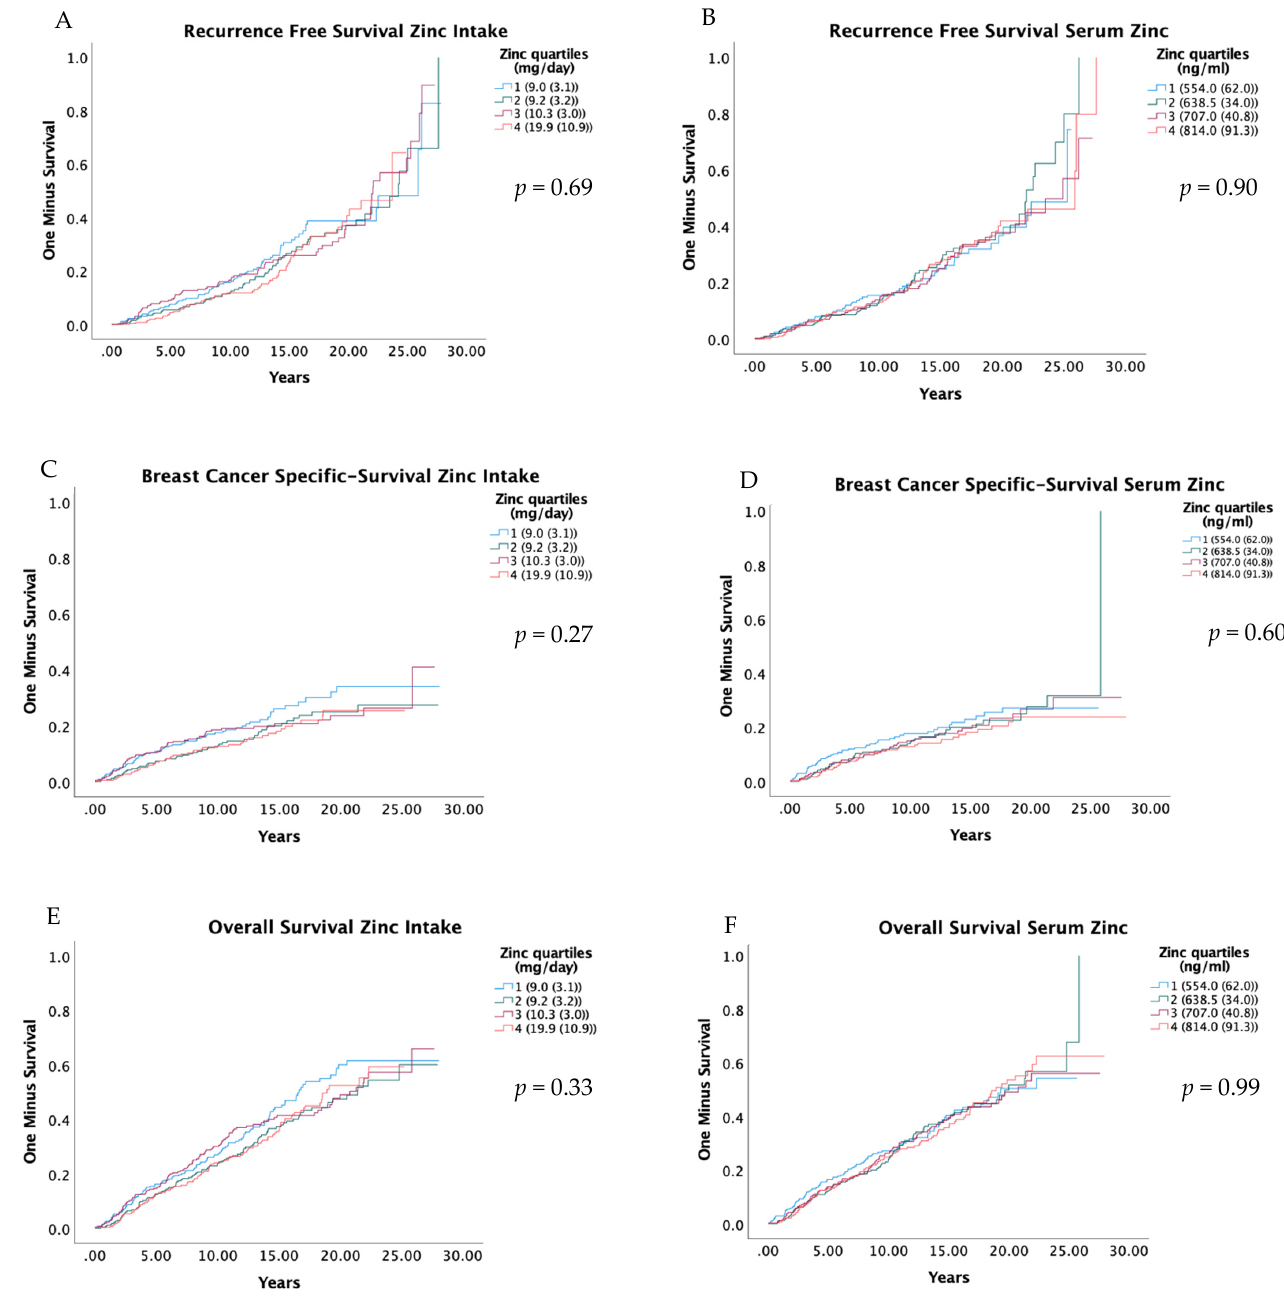
Figure 2. Kaplan-Meier curves for recurrence free survival ( A , B ), breast cancer-specific survival ( C , D ), and overall survival ( E , F ), by quartiles of zinc intake and serum zinc. Log-Rank-Test was used to evaluate differences. Residuals are presented as the median and interquartile range of total dietary intake of zinc. Quartiles of serum zinc are shown as median and interquartile range. When the data were stratified for different levels of phosphorus intake, no association between zinc intake and RFS was seen (Table 4). However, in women with a high phos- phorus intake (above the median), a higher BCSS was seen in the dichotomized group of zinc intake Q2 to Q4 versus Q1; the adjusted HR was 0.41 (0.23–0.73) (P i = 0.01) (Table 4). Likewise, the adjusted HR for OS in zinc intake Q2 to Q4 versus Q1 was 0.64 (0.41–1.00) (P i = 0.10) (Table 4). When using serum zinc as an indicator of zinc status and stratifying for serum phosphorus levels, no associations with RFS, BCSS or OS were seen (Table